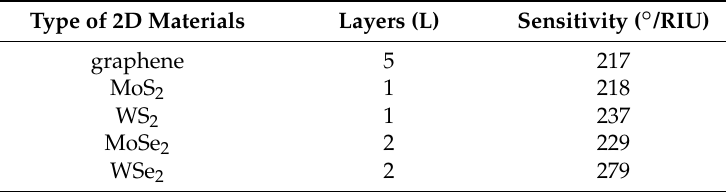
Table 2. Original results in reference [17].